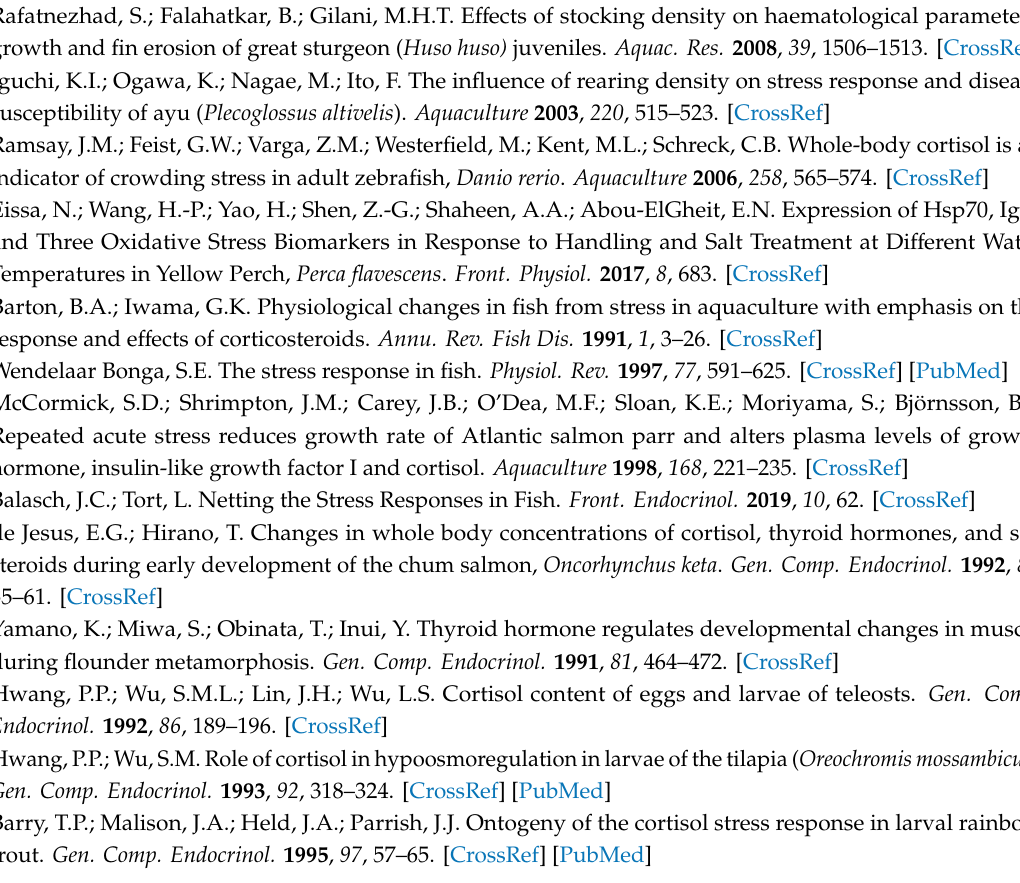
Table S1: LD gene expression raw